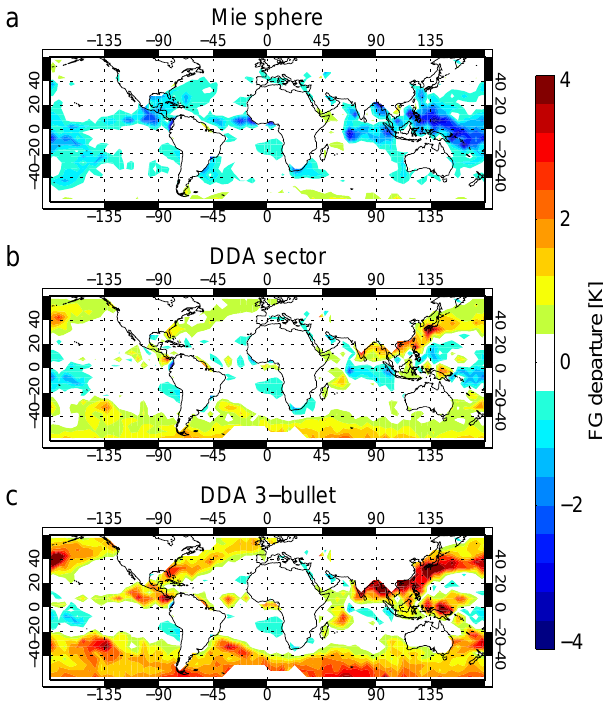
Figure 8. June 2012 mean FG departures in the 183 ± 7GHz chan- nel on SSMIS; other details as Fig.